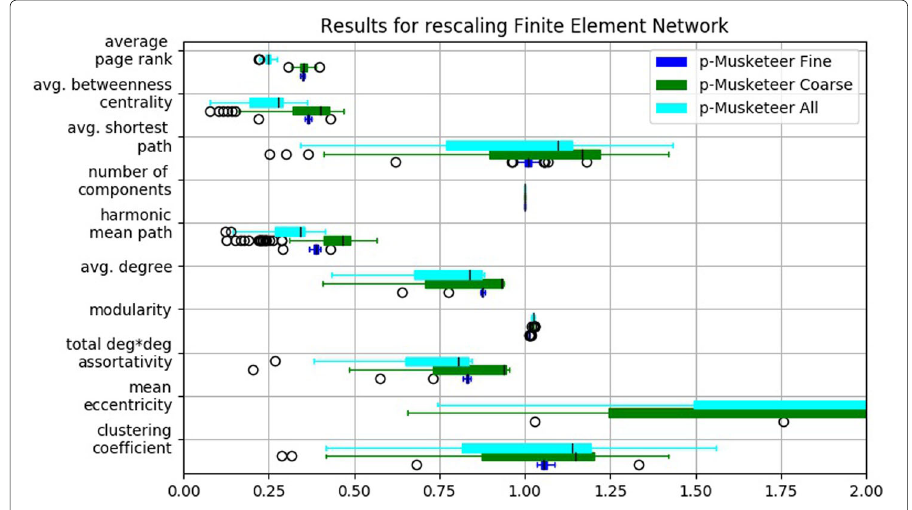
Fig. 18 Computational results for road network real water network with 407 nodes and 459 edges rescaled to at least 1098 nodes and 1500